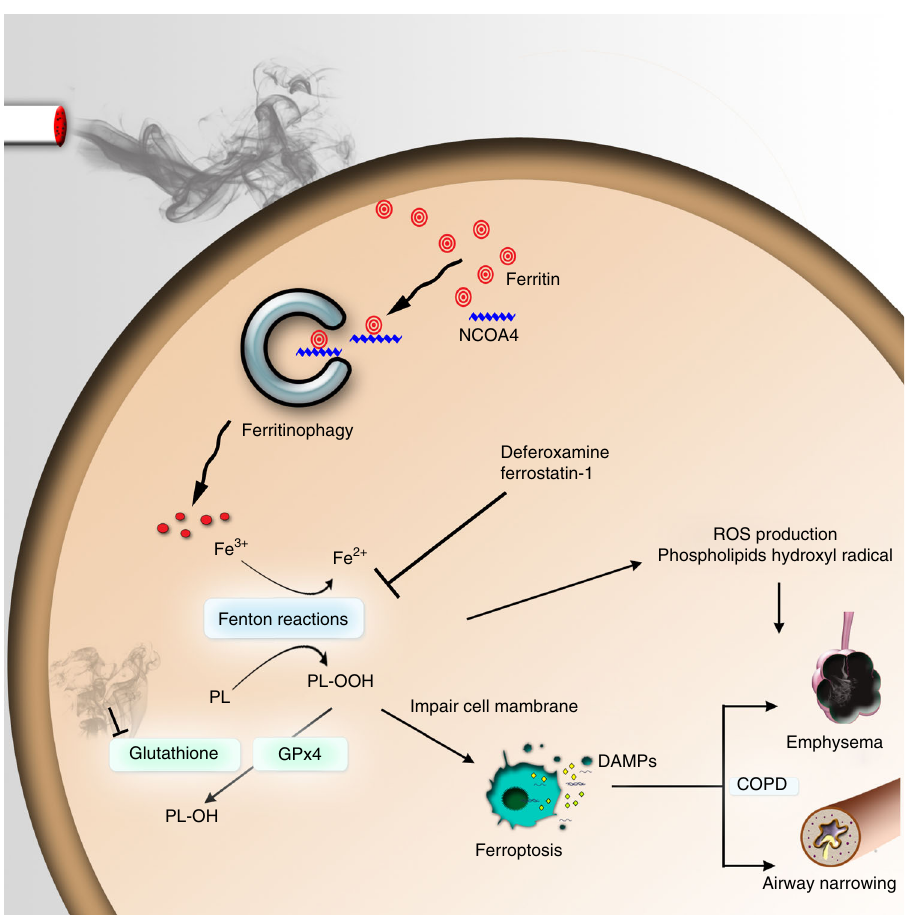
Fig. 6 Schematic representation of smoking induced ferritinophagy and ferroptosis. Cigarette smoke increases intracellular ferritin and decreases intracellular glutathione transiently. Ferritin is delivered to autophagosomes by NCOA4 and is degraded to non-heme iron via ferritinophagy. The excess of free iron leads to generation of reactive oxygen species and lipid peroxidation through Fenton reactions, which can be regulated by deferoxamine, ferrostatin-1, and GPx4. Lipid peroxidation leads to cell membrane disruption, including in mitochondoria, resulting in ferroptosis. DAMPs and ROS released from ferroptotic cells are implicated in COPD